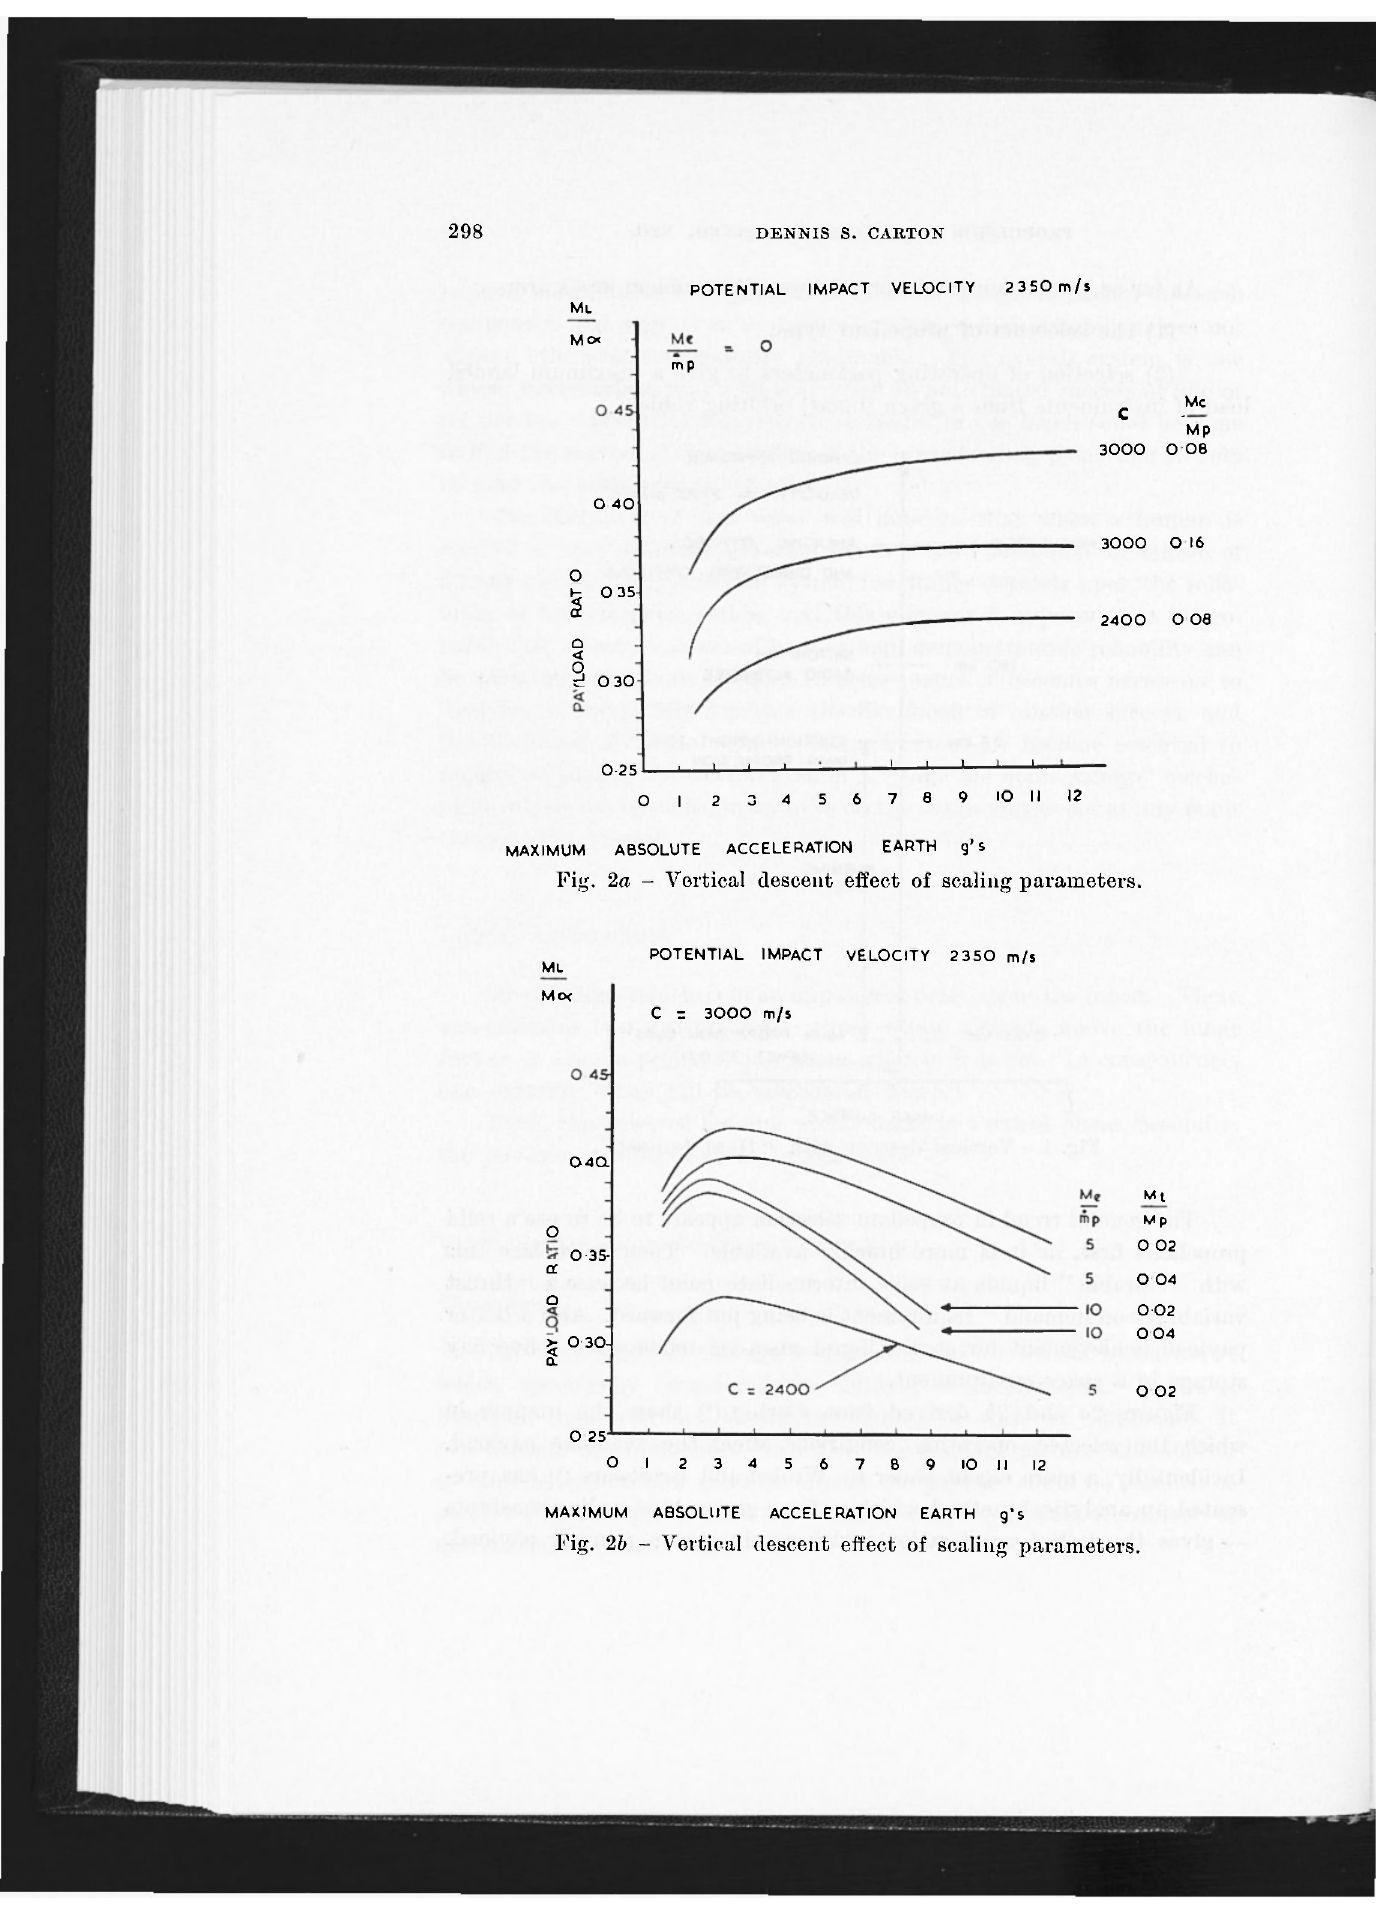
Fig. 2a - Vertical descent effect of scaling parameters.